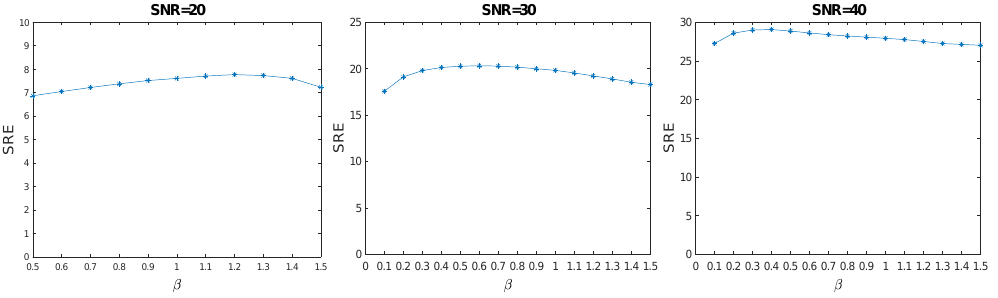
Figure 8. SRE (dB) as a function of parameter β for DC1 with different noise levels. From left to right: SNR = 20 dB, α 1 = 0.05, α 2 = 1; SNR = 30 dB, α 1 = 0.01, α 2 = 1; and SNR = 40 dB, α 1 = 0.001, α 2 = 0.1.